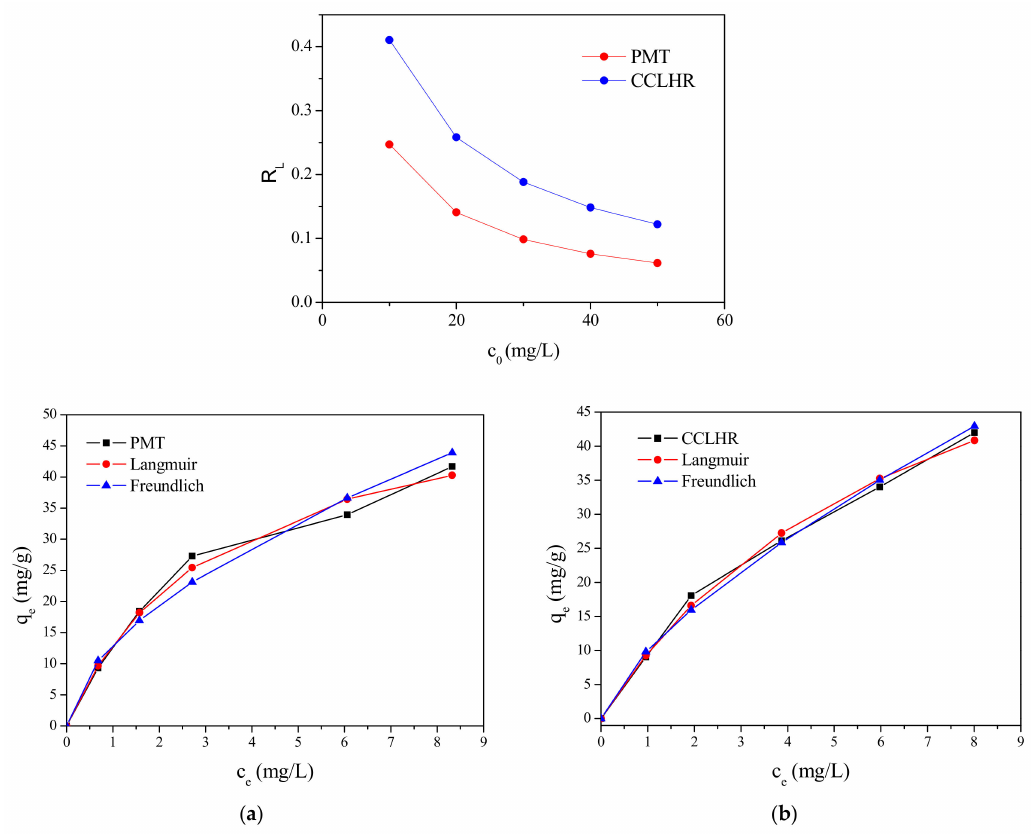
Figure 8. Adsorption isotherms with the Langmuir and Freundlich models: ( a ) PMT, ( b ) CCLHR.